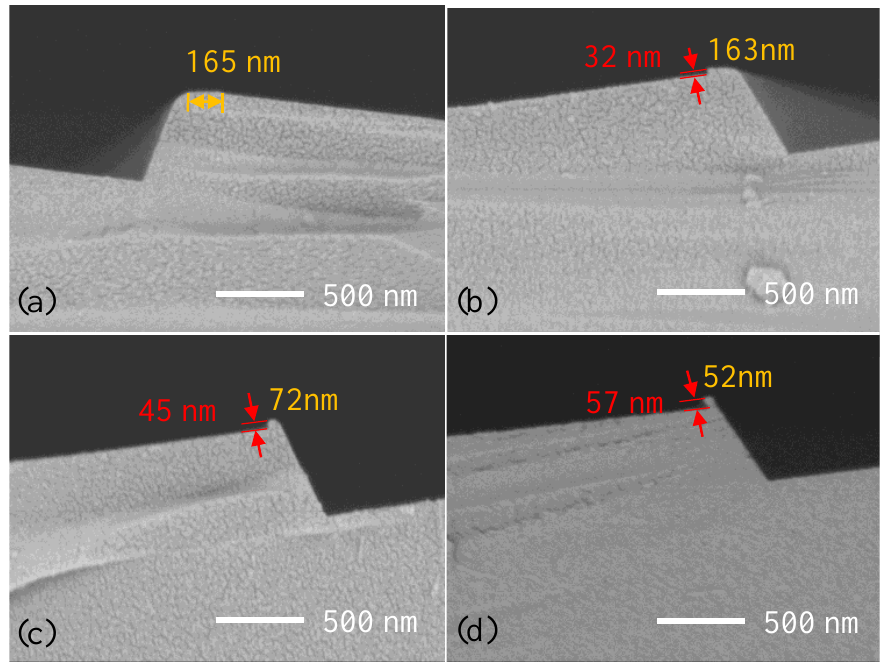
Figure 9. Grating grooves etched by different time. ( a ) 75 s; ( b ) 3 min; ( c ) 5 min; and ( d ) 7 min.